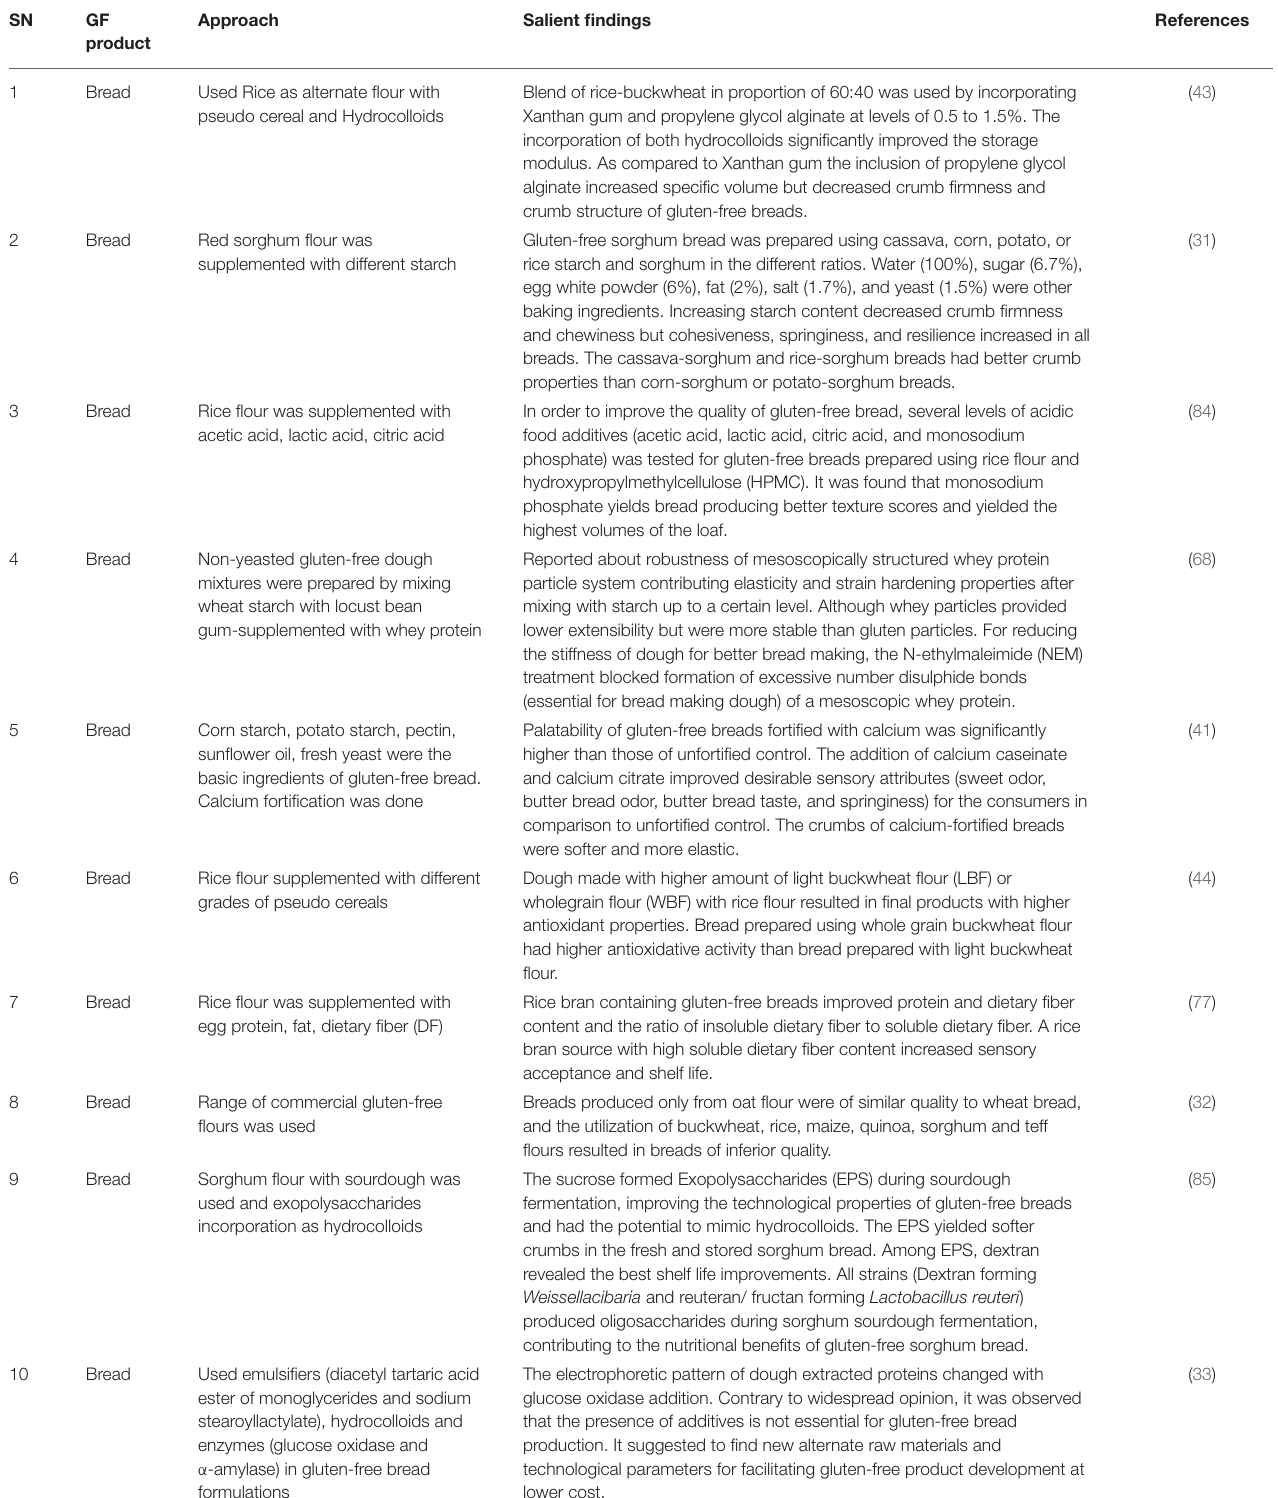
Bread Used emulsifiers (diacetyl tartaric acid ester of monoglycerides and sodium stearoyllactylate), hydrocolloids and enzymes (glucose oxidase and α -amylase) in gluten-free bread